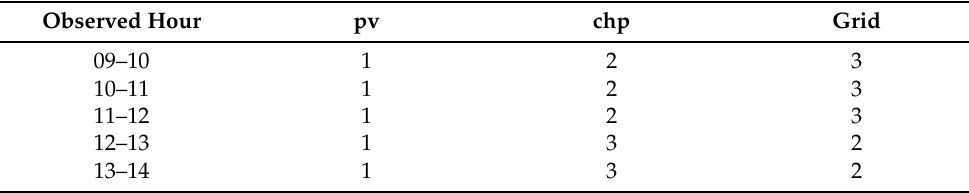
Table 4. Example priority numbers (1 is highest) derived from capacity shares (electricity).